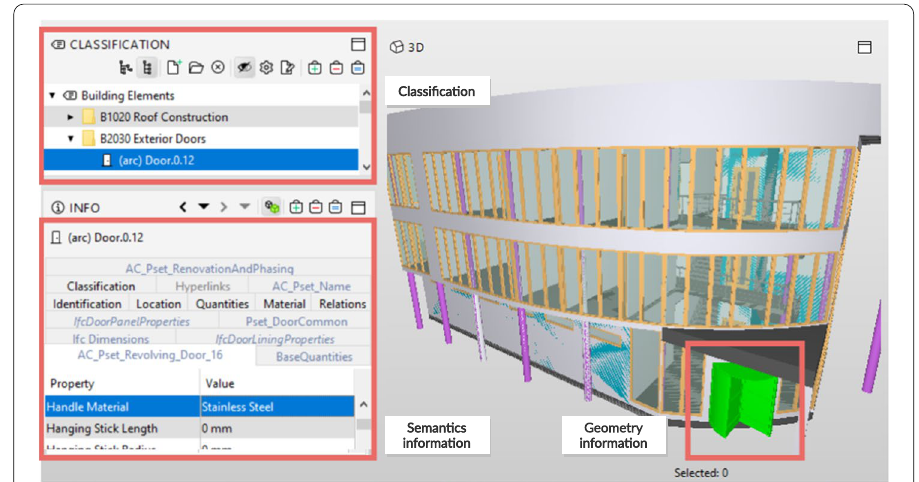
Fig. 1 Visualization of semantic, geometric information of a BIM element (Door) in an IFC file with Solibri